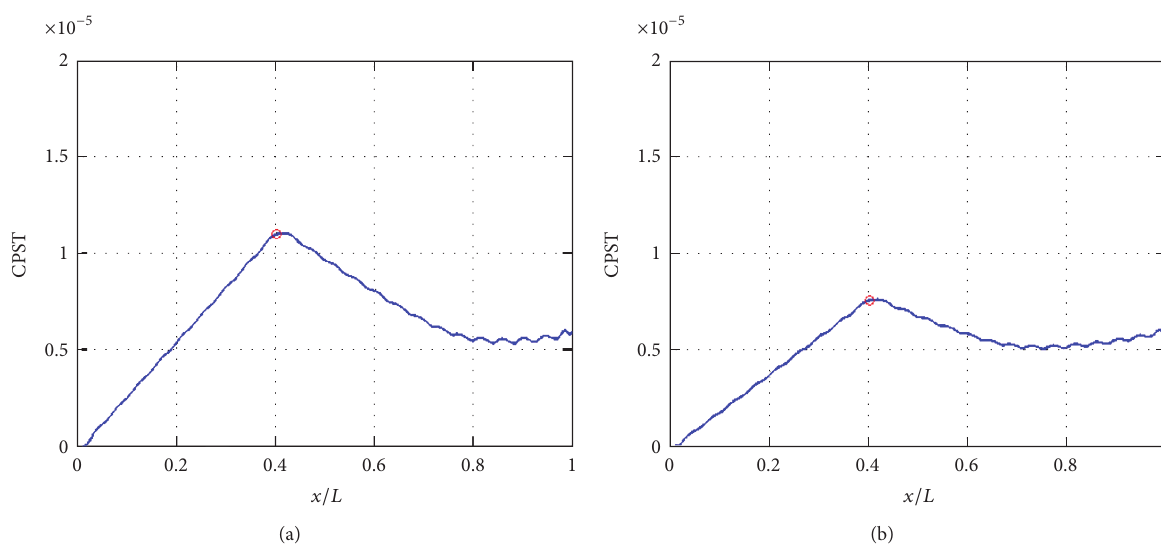
Figure 23: CPST of different sensor location scenarios using displacement responses with damaged level is 10%, mass is 200 Kg, and velocity is 1m/s: (a) sensor location is 𝐿 𝑠 = 0.25 and (b) sensor location is 𝐿 𝑠 = 0.75